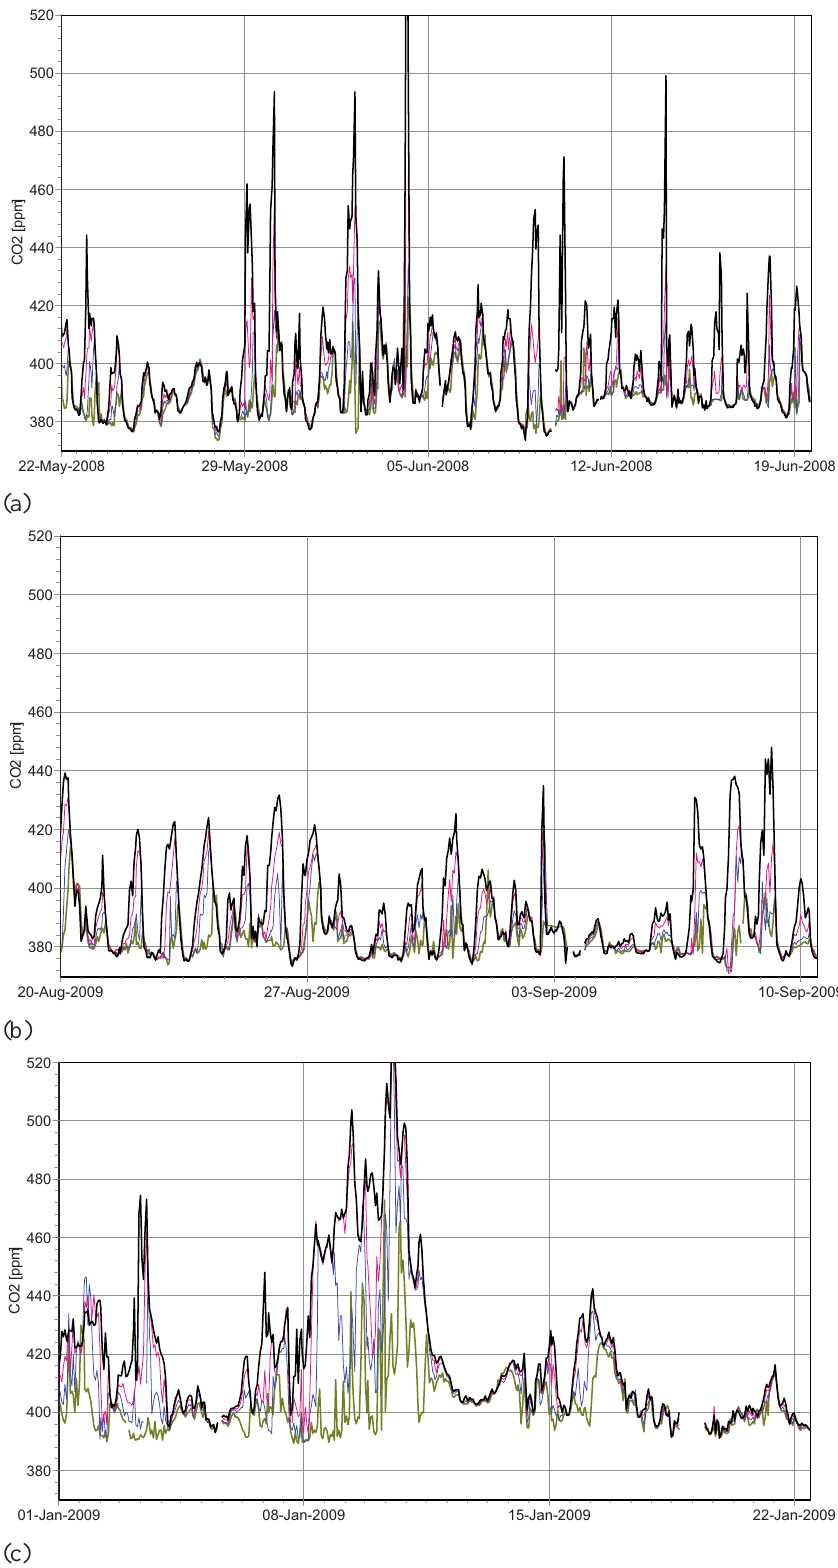
Fig. 12. Time series for the CO 2 concentration gradient at Cabauw for three weeks spring and early summer 2008 (a) , three weeks in autumn 2008 (b) , and three weeks in winter 2008/2009 (c) . Colours as in Fig. 10.